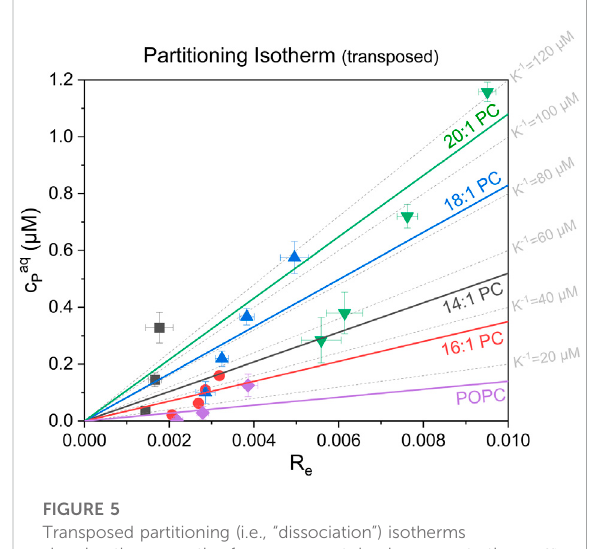
FIGURE 5 Transposed partitioning (i.e., “ dissociation ” ) isotherms showing the respective free, aqueous tolaasin concentration, c P aq (µM) as a function of the equilibrium tolaasin-to-lipid mole ratio within the membrane, R e , for the different lipids studied (see plot). The error bars are standard errors of R e and c P aq from the linear fi t of the equi-activity analysis. The colored lines represent instrumental-error-weighted, linear fi ts of the “ dissociation isotherms ” for each tested lipid (see color code in fi gure). Their slope represents the apparent membrane dissociation constant (i.e., reciprocal apparent membrane-buffer partition coef fi cient), K − 1 for tolaasin with the tested lipids (see color code in the fi gure). Grey dotted grid lines display fi ctive isotherms for selected K − 1 values.